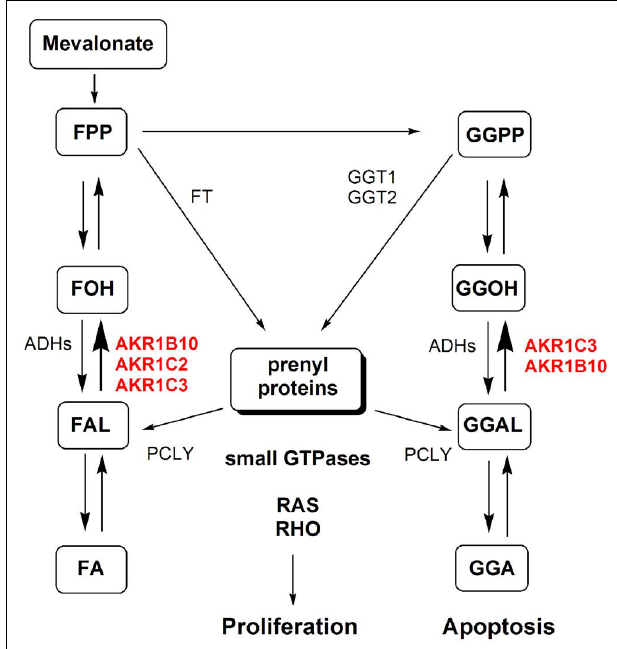
FIGURE 3 |The implications ofAKR1B andAKR1C enzymes in protein prenylation. Prenylation involves transfer of farnesyl pyrophosphate (FPP) or geranylgeranyl pyrophosphate (GGPP) by farnesyltranserase (FT) and geranylgeranyltransferase 1 and 2 (GGT1 and GGT2), respectively, to various proteins including small GTPases (RAS and RHO).The reverse reaction that releases farnesal (FAL) and geranylgeranial (GGAL) is catalyzed by prenylcystein lyase (PCLY). Farnesyl pyrophosphate and geranylgeranyl pyrophosphate thus serve as substrates of FT and GGT1/GGT2 but can also be dephosphorylated to form farnesol (FOH) and geranylgeranyol (GGOH). FOH and GGOH are oxidized to FAL and GGAL by alcohol dehydrogenases (ADHs) and by yet unidentified enzymes to farnesoic acid (FA), geranylgeranoic acid (GGA) and other metabolites.The reduction of FAL and GGAL to FOH and GGOH is catalyzed by AKR1B and AKR1C enzymes.This reaction indirectly recovers substrates for further formation of active prenyl-pyrophosphates. Additionally, reduction of GGAL to GGOH prevents formation of GGA and the metabolites with potential apoptotic effects. (Adopted from Endo et al.,